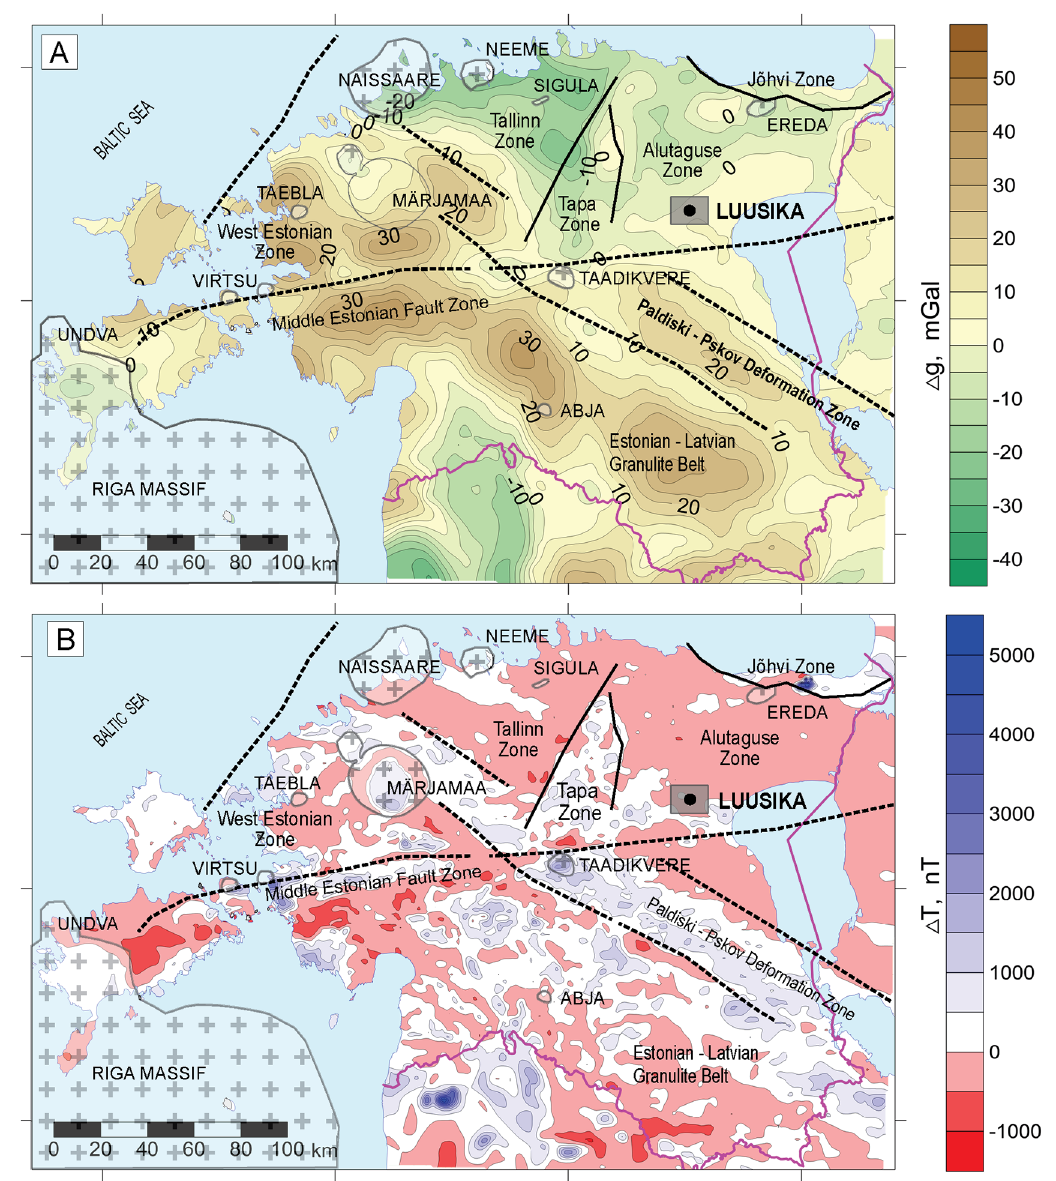
Fig. 1. Structural features and metamorphic complexes of the Precambrian basement compared to ( A ) Bouguer gravity and ( B ) magnetic anomaly maps. Non-marked areas represent Svecofennian metamorphic and plutonic rocks; crossed areas are anorogenic complexes of rapakivi and related granites. Geological data are after Puura et al. (1997) and Bogdanova et al. (2015). Geophysical overview maps are by the Geological Survey of Estonia. The grey square indicates the location of the studied Luusika